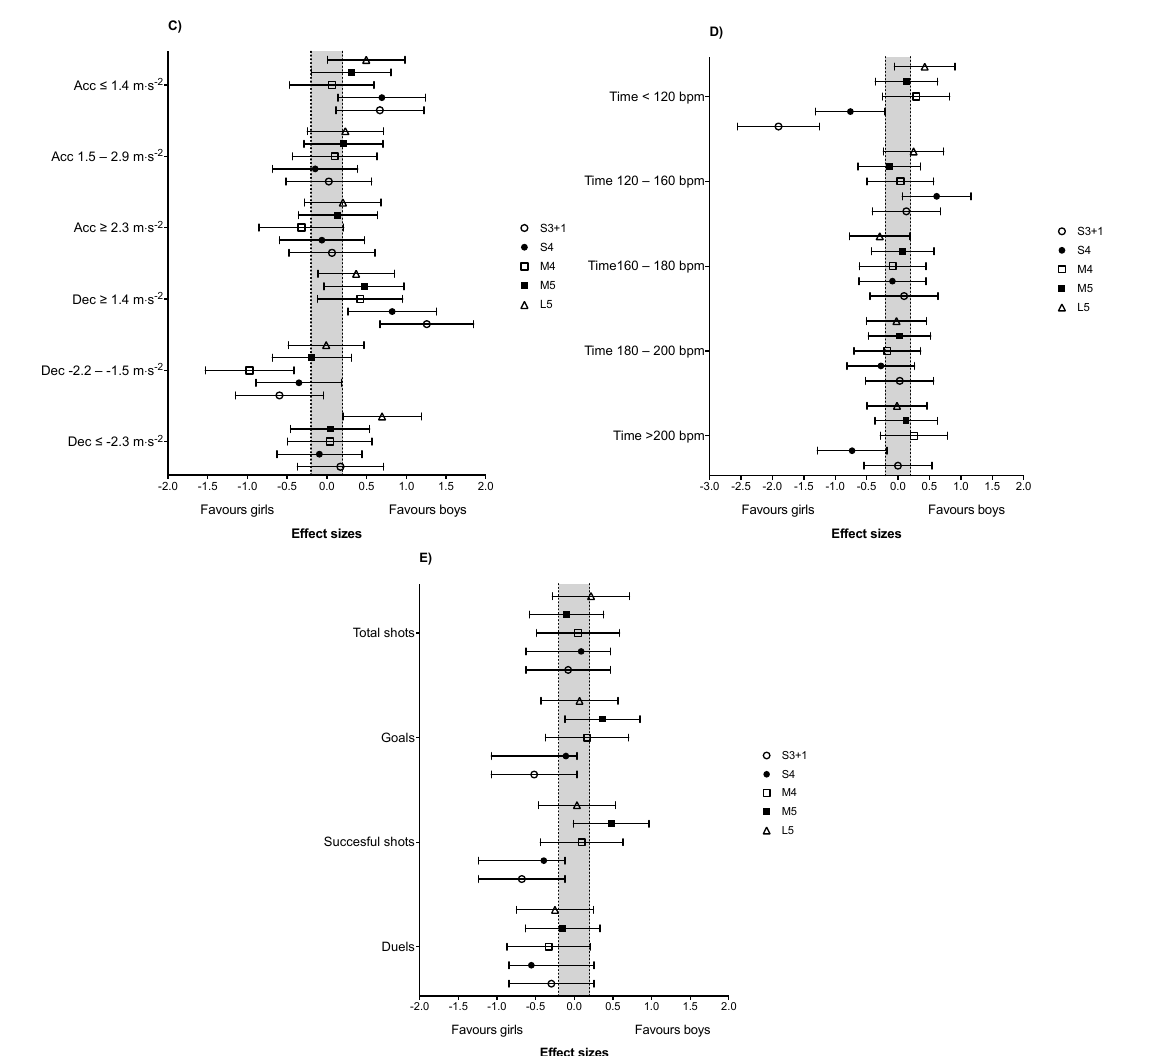
Figure 5. Differences in ( A ) overall physical and physiological demands, ( B ) activity profile, ( C ) accelerations and decelerations, ( D ) heart rate, and ( E ) technical demands between boys and girls during different U9 handball games. The forest plots are effect sizes (90% CI). S3 + 1: small size, 3 v 3 + offensive goalkeeper; S4: small size, 4 v 4; M4: medium size, 4 v 4; M5: medium size, 5 v 5; L5: large size, 5 v 5. St/W: standing/walking; MSR: moderate-speed running; HSR: high-speed run- ning.